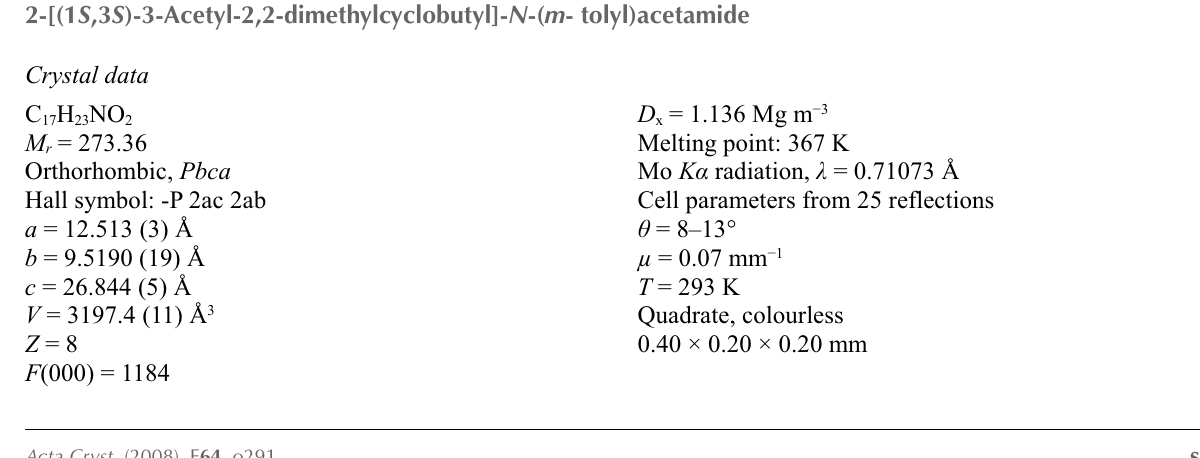
A view of the packing and N—H···O hydrogen bondings (dash lines) of the title compound. 2-[(1 S ,3 S )-3-Acetyl-2,2-dimethylcyclobutyl]- N -( m -